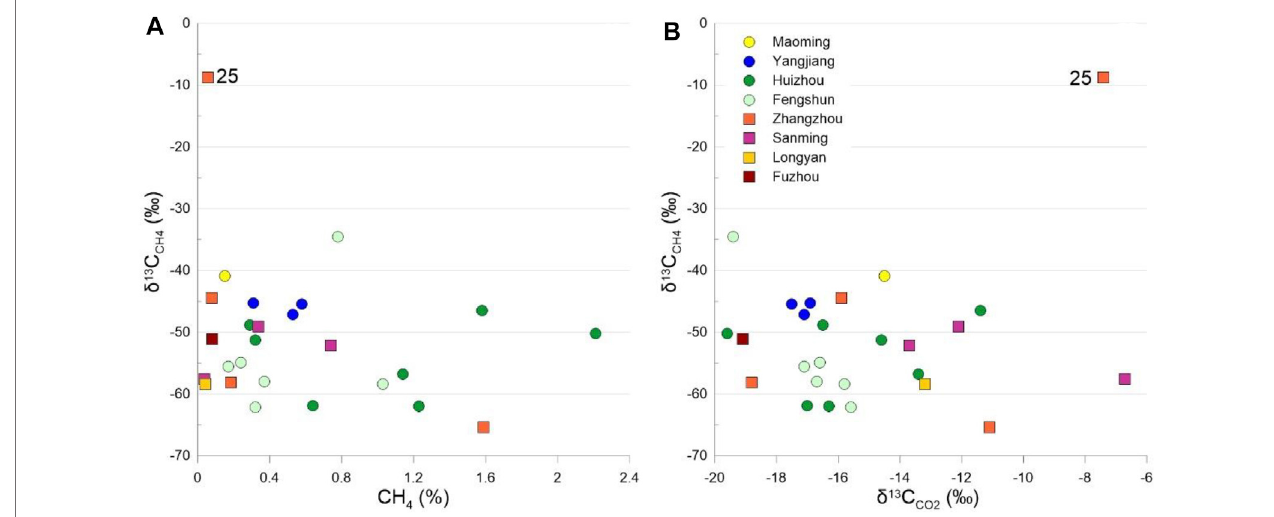
FIGURE 7 | Calculated heat fl ow and its contribution of crust and mantle according to He isotopic ratios of hydrothermal volatile.